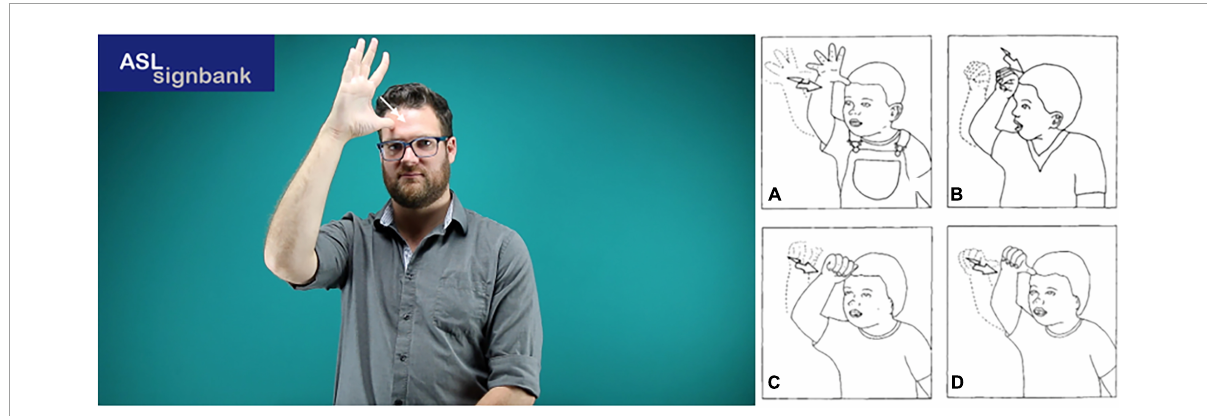
FIGURE2 Handshape substitution errors produced by an ASL-acquiring child. (Left) Target form FATHERstr (reproduced with permission from ASL Signbank; Hochgesang et al., 2021). (Right) Child forms (A–D) [Copyright (2020) From Conlin et al. (2000: p. 60). Reproduced by permission of Taylor and Francis Group, LLC, a division of Informa